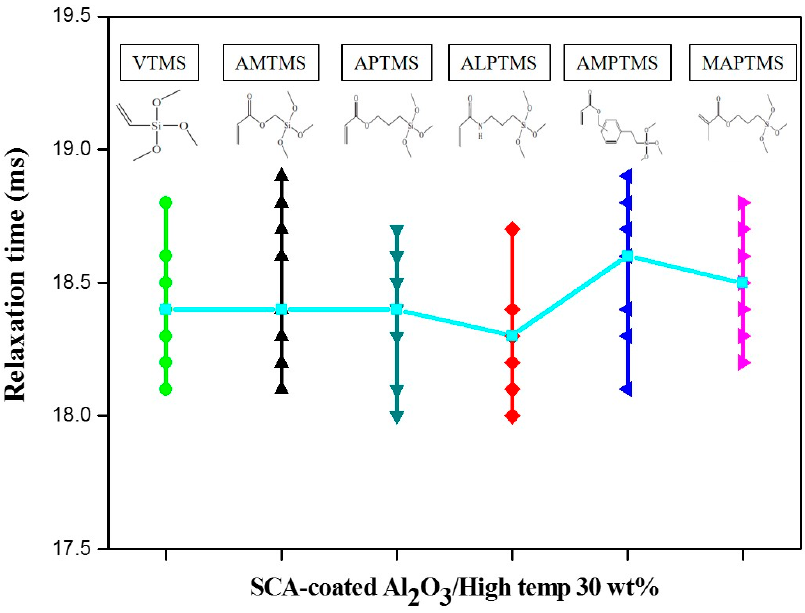
Figure 4. Relaxation times of the SCA-coated Al 2 O 3 /High-temp composite solutions with different organofunctional groups.